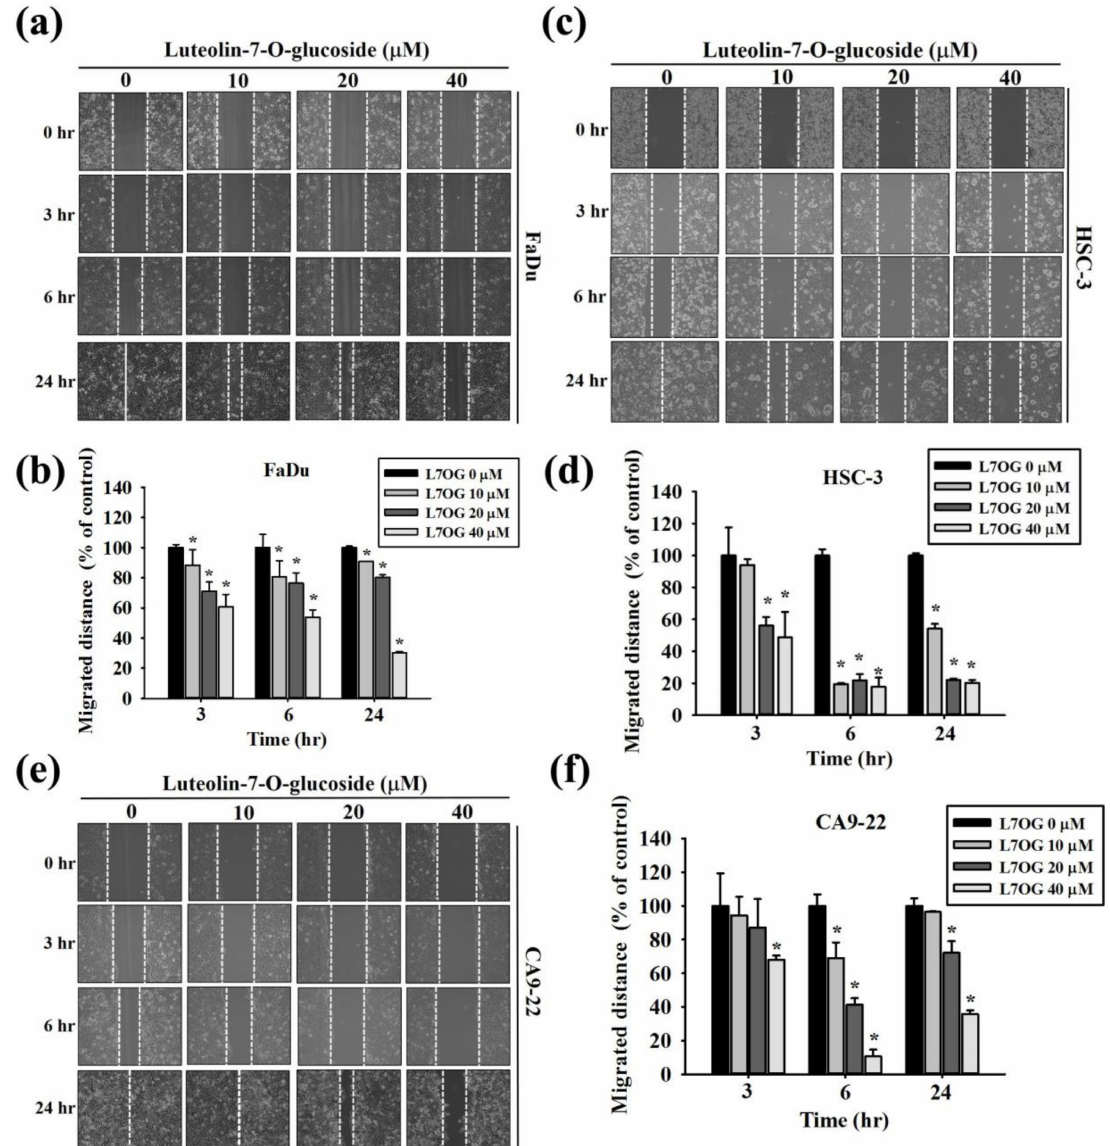
Figure 2. Luteolin-7-O-glucoside inhibits cell motility inhuman oral cancer cells. The e ff ect of luteolin-7-O-glucoside treatment on cell motility was analyzed in ( a , b ) FaDu, ( c , d ) HSC-3, and ( e , f ) CA9-22 cells. The values are represented as mean ± SD of at least three independent experiments. * p < 0.05, compared with the control